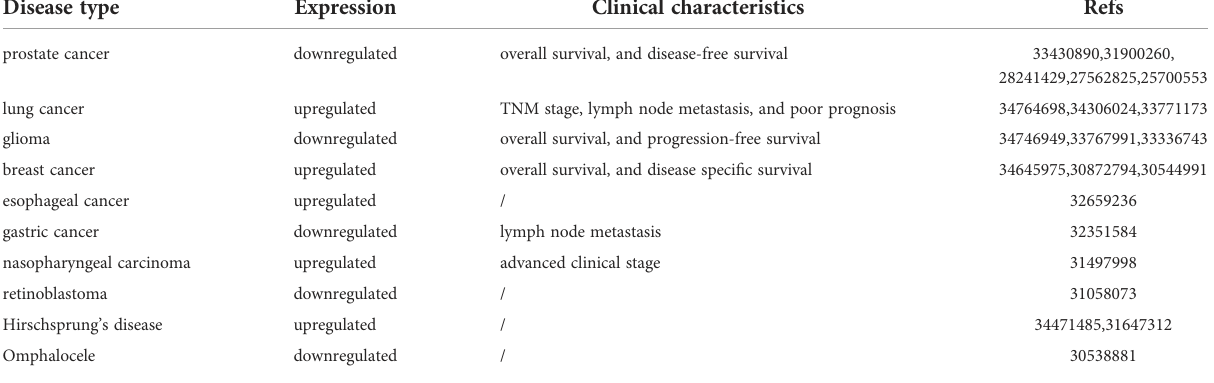
TABLE 1 lncRNA DRAIC expression and clinical characteristics in human diseases.